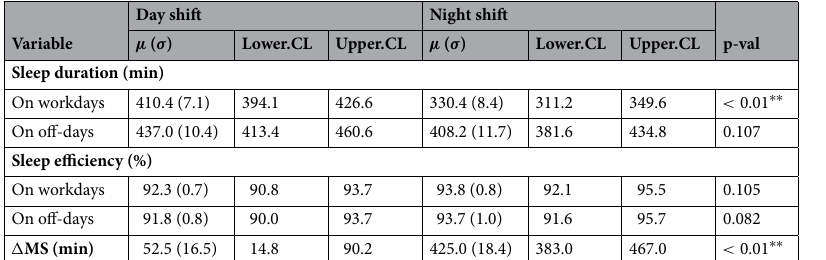
Table 4. Table showed the sleep pattern (in estimated marginal means) comparisons between day shift nurses and night shift nurses. Statistical significance was denoted as p ∗∗ < 0.01 , p ∗ < 0.05